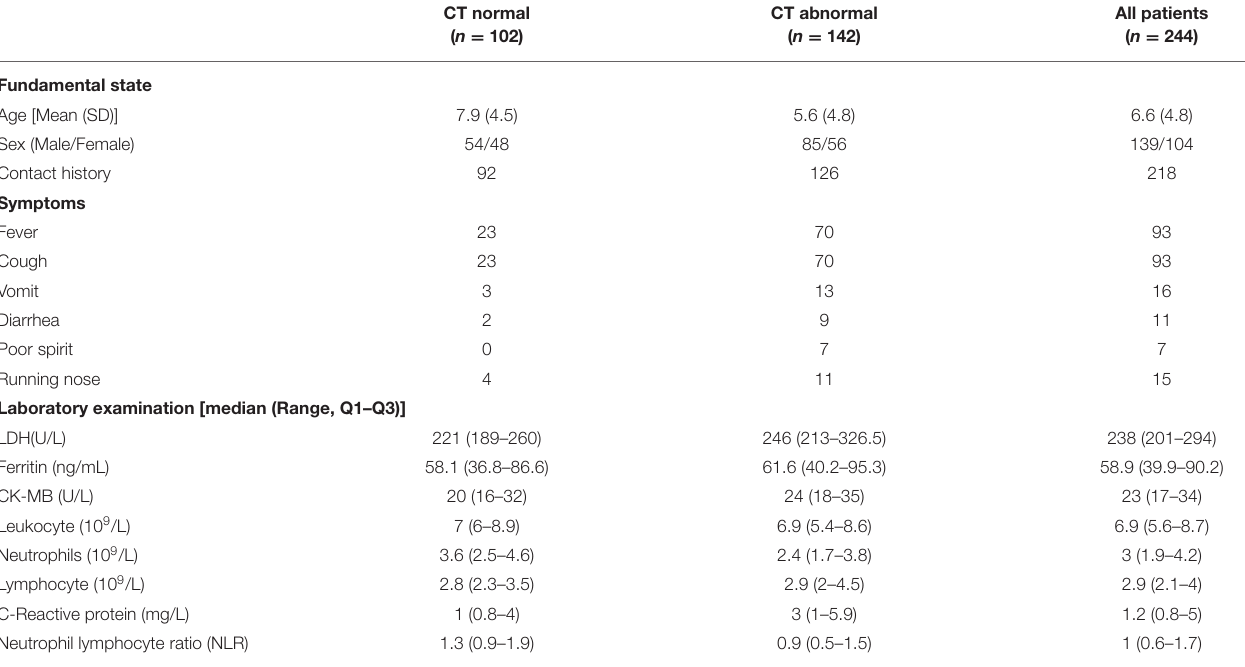
TABLE 1 | Baseline characteristics of children with